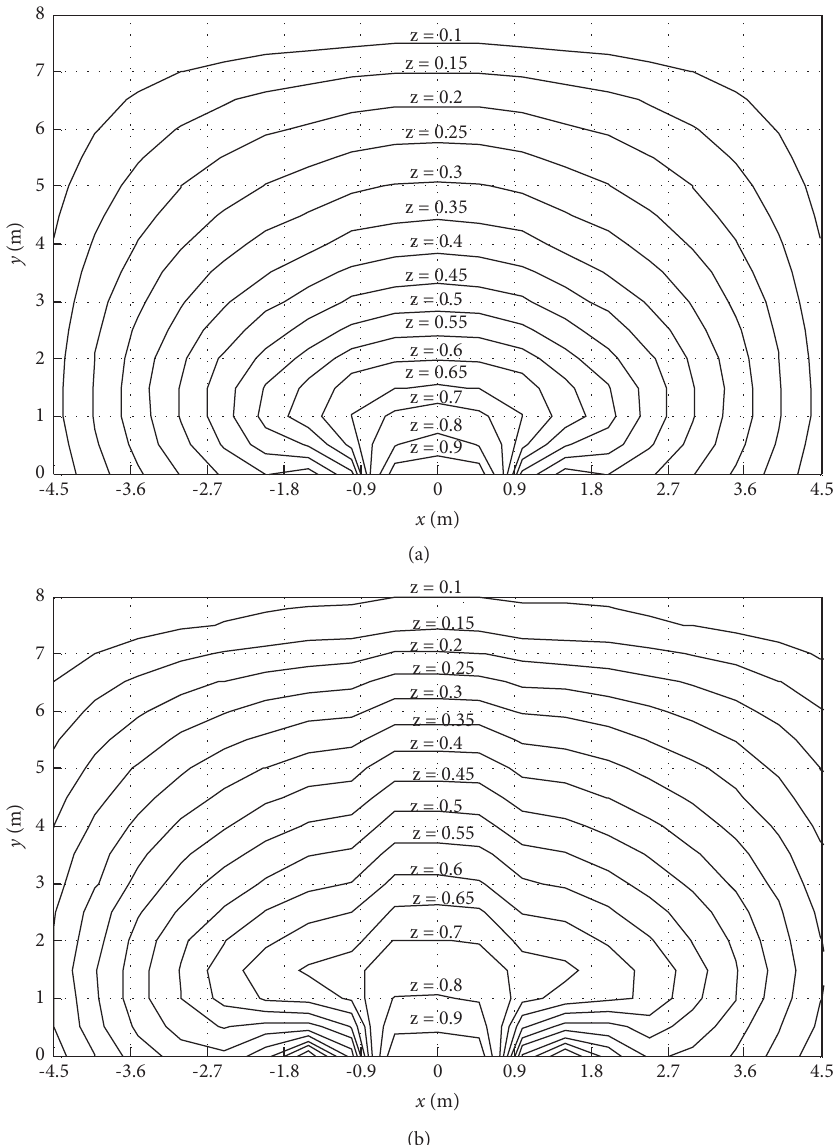
Figure 5: Peak pressure space distributions of Schemes 1 and 2. (a) Scheme 1. (b) Scheme